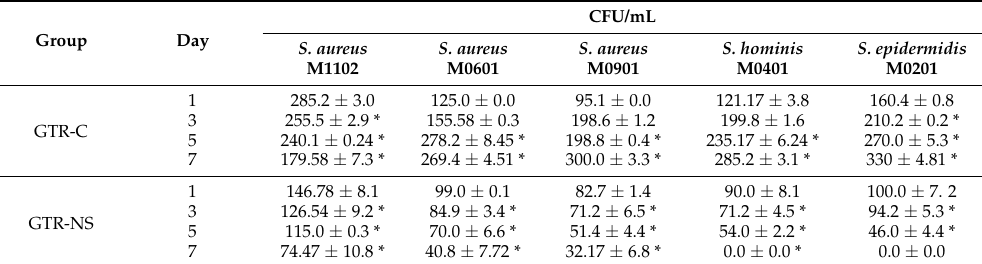
Table 6. Bacterial penetration of control (GTR-C) and silver-nanoparticle (GTR-NS)-impregnated collagen guided tissue regeneration (GTR)